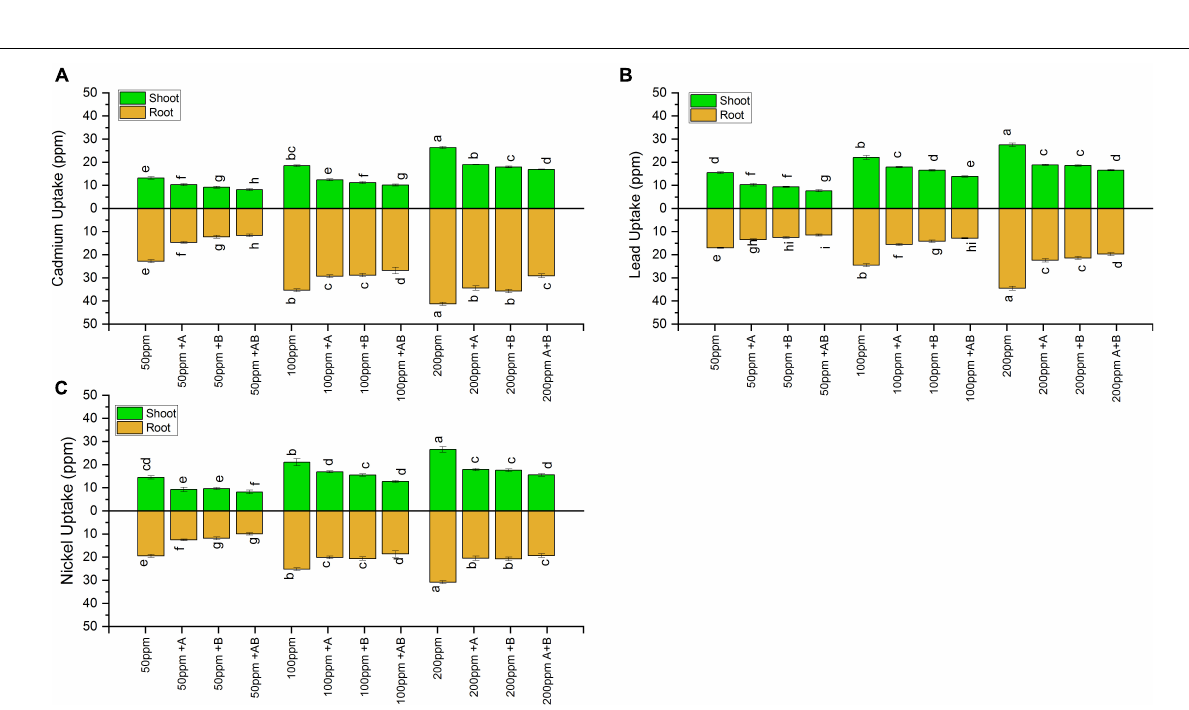
Frontiers in Microbiology |